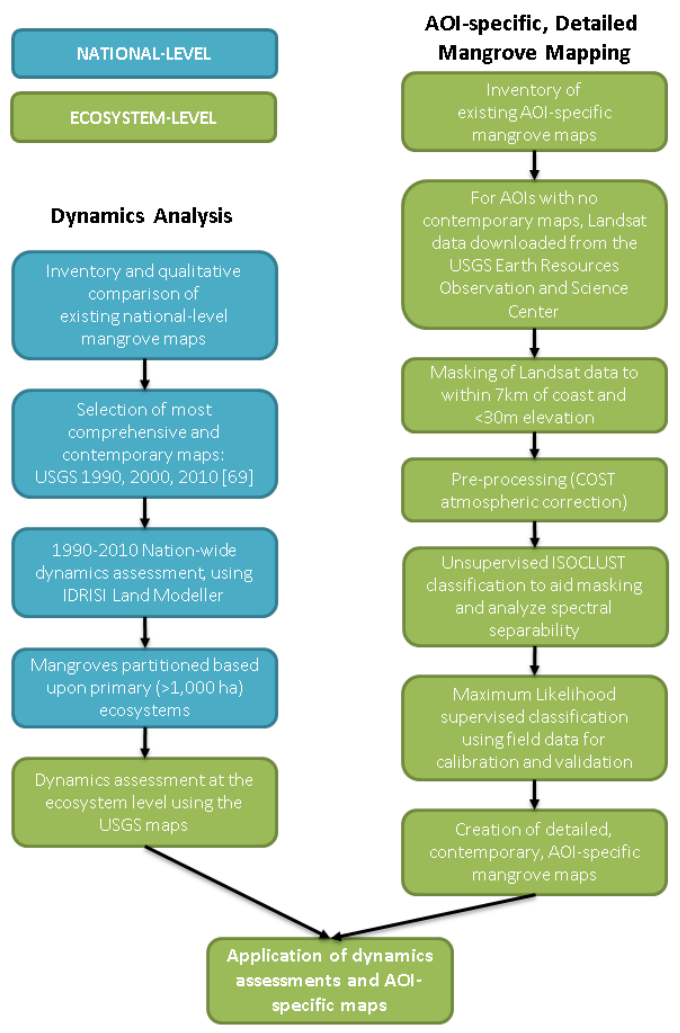
Figure 2. Workflow. Blue boxes represent national-level processing including the entire distribution of Madagascar’s mangroves. Green boxes represent ecosystem-level processing, including 30 primary mangrove ecosystems, with focus on four AOIs ( i.e. , Ambaro-Ambanja Bays (AAB), Mahajamba May (MHJ), Tsiribihina-Manambolo Delta (TMD) and Baie des Assassins (BdA)). The results of nation-wide